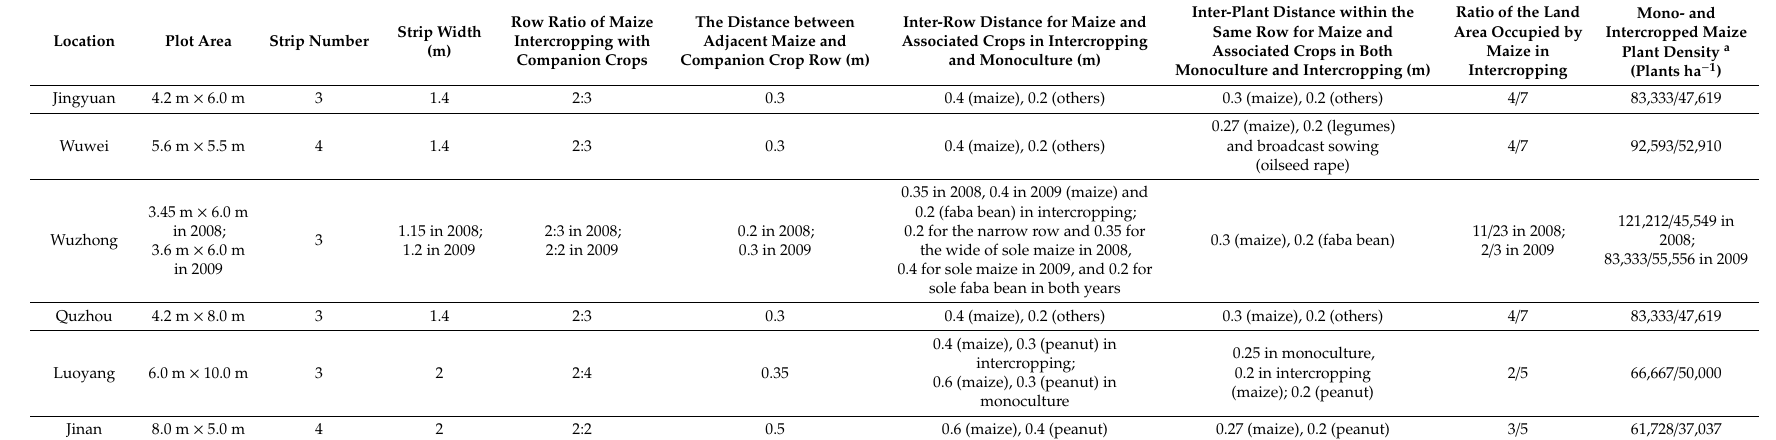
Table 4. Detailed spatial arrangements of maize and associated crops in monocropped and intercropped plots in di ff erent experimental